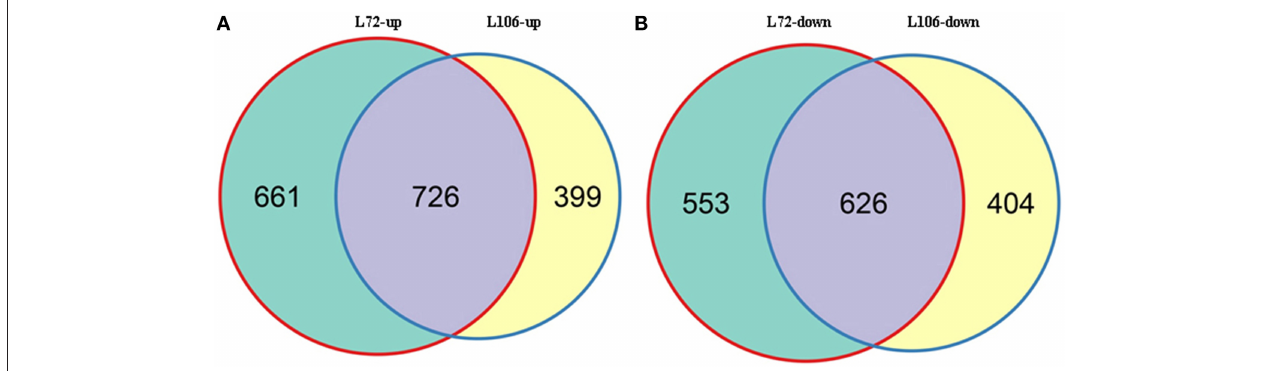
FIGURE 4 | Overlap between differentially-expressed genes (DEGs) in two B. napus accessions (L72: MUTU and L106: Alku). Venn diagrams display overlap between DEGs in L72 (green) and L106 (yellow) after exposure to − 1.0MPa (S10) water stress for 6h. (A) , intersection of DEGs up-regulated in L72 with those up-regulated in L106; (B) , intersection of DEGs down-regulated in L72 with those down-regulated in